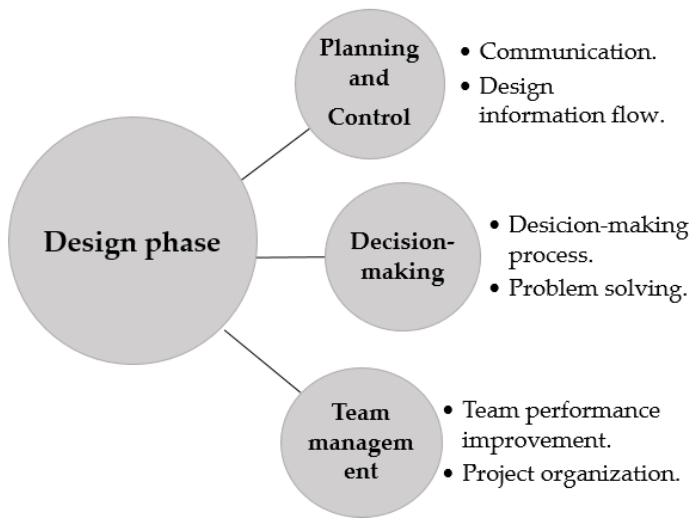
Figure 4. The main parts of the design phase with their different tasks.